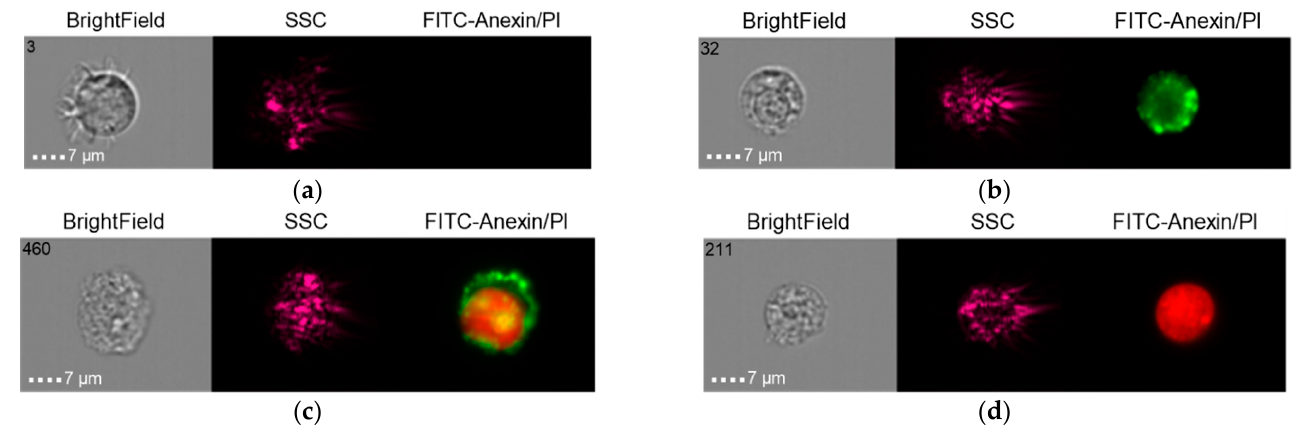
Figure 13. Live cells ( a ), early apoptosis ( b ), late apoptosis ( c ), necrosis ( d ) after co-culture of Alpha Bio NSMP with THP-1 cell line (Alpha Bio NSMP +THP-1).